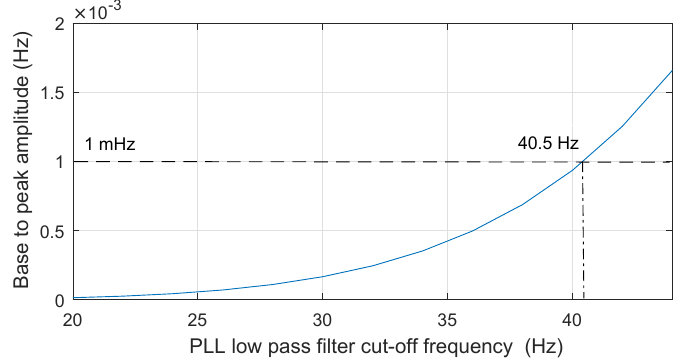
Figure 2. Base to peak amplitude of PLL output measured frequency around steady-state value as function of f c of PLL, when harmonics are considered